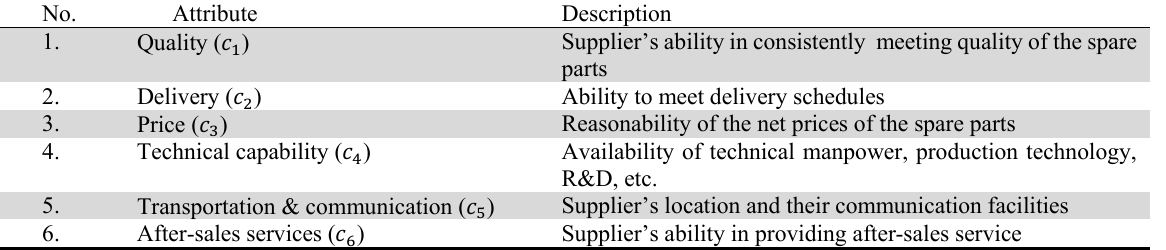
Attributes for evaluating performance of spare parts suppliers